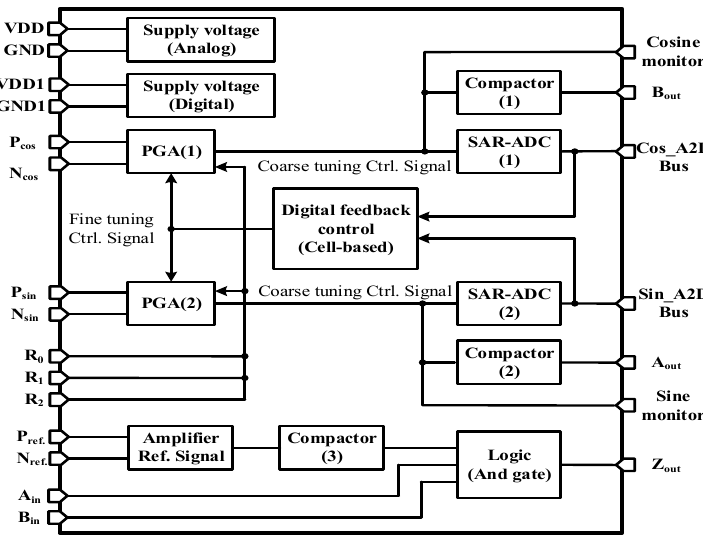
Figure 10. Architecture of the adaptive encoder IC.